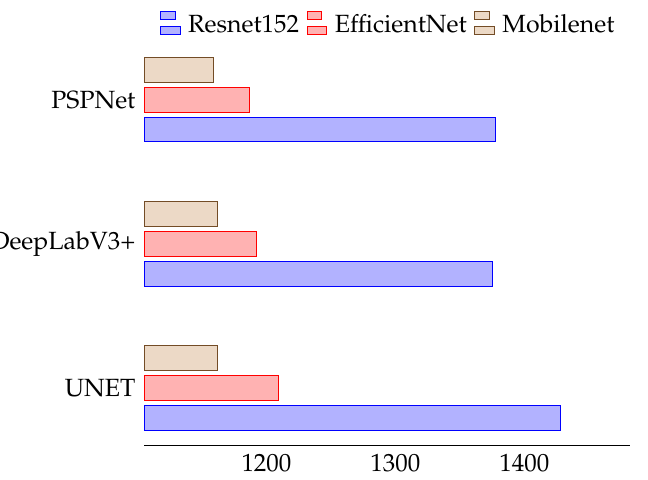
Figure 10. Memory footprint (in MB) for every model, and with every